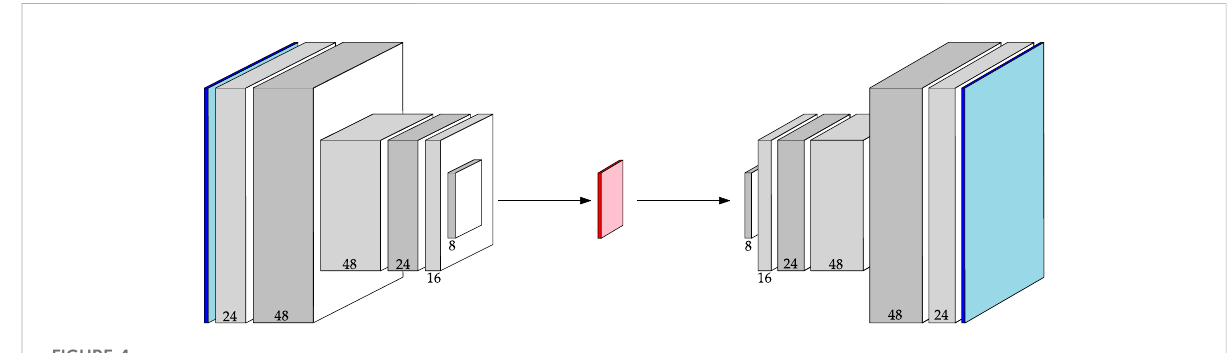
FIGURE 4 Architecture of the BASELINE CAE . Channel numbers are shown at the bottom of each block. Reference Table 2 for a detailed